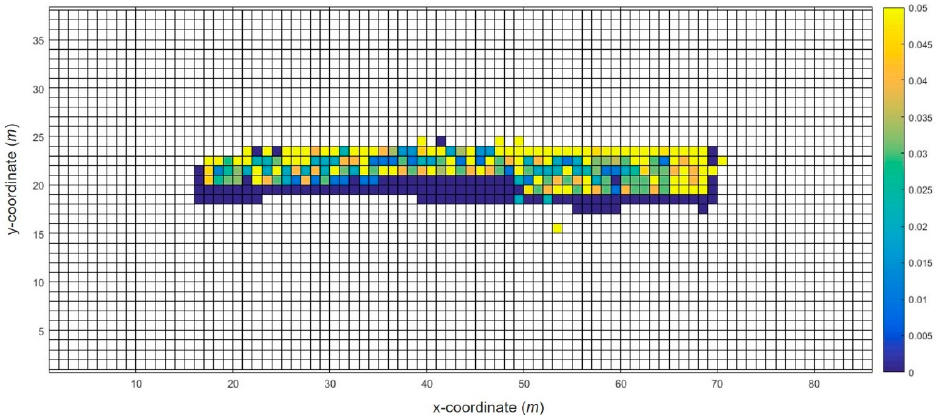
Figure 3. Modified WRM heat map of the test bed example.